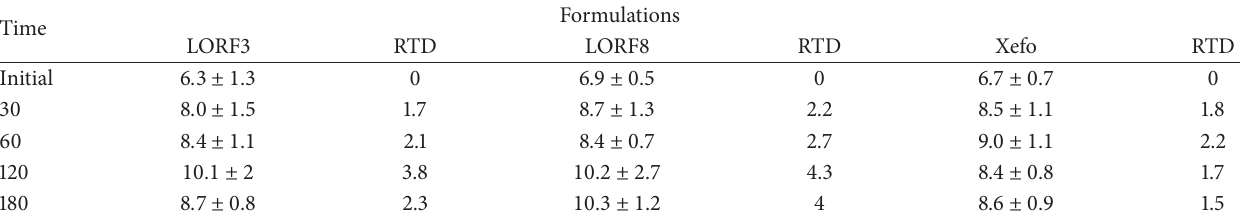
Table 4: Analgesic activity of LOR formulations at a dose of 0.04 mg compared to injectable LOR dosage form (Xefo) on mice.